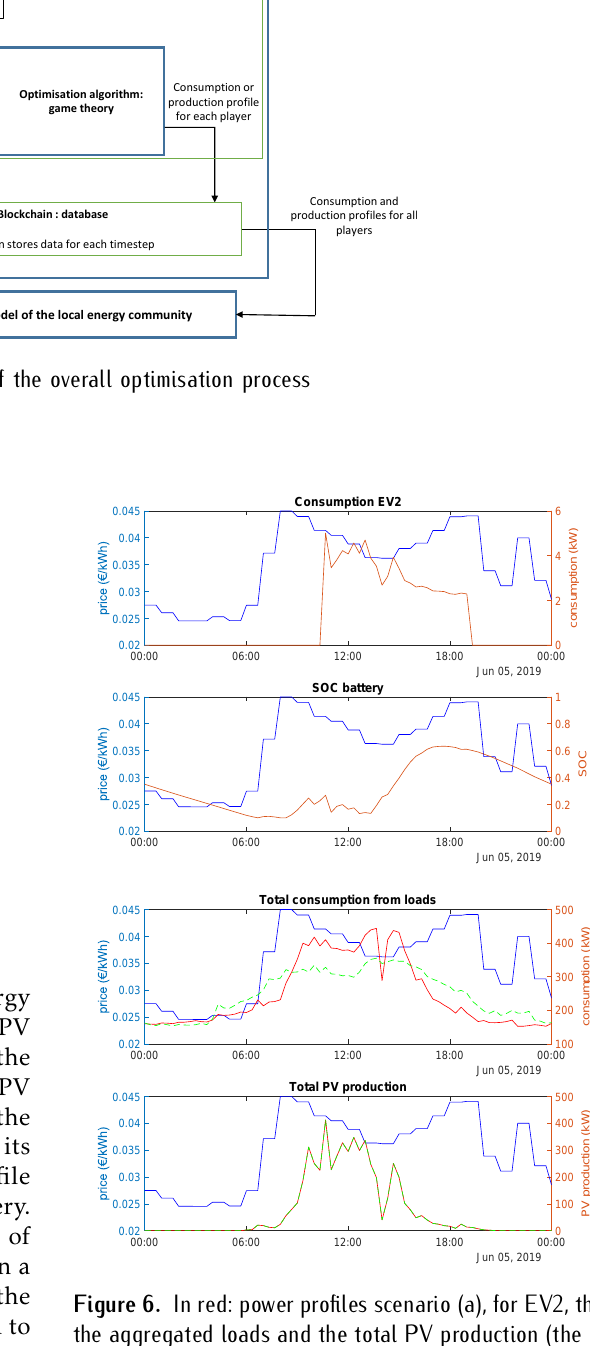
cases. Second, scenario (a) is more interesting for the distribution grid, because it avoids the morning and night peaks, it decreases the power send back to the grid and the power imported show less fluctuations (the standard deviation is only 63 kW in scenario (a), and 105 kW in scenario (b)). This is due to the will of